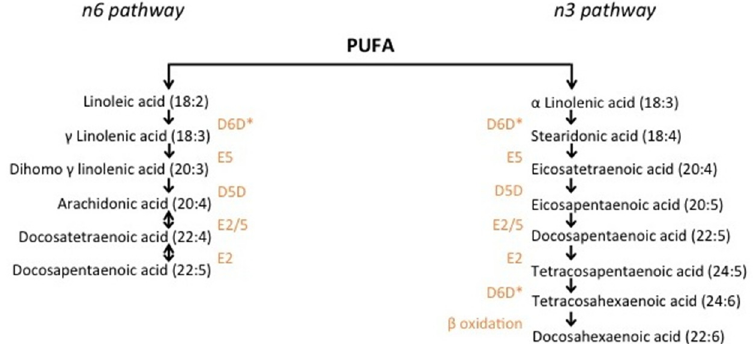
Figure 1. Synthesis of polyunsaturated fatty acids through the n ‐ 3 and n ‐ 6 pathways. Polyunsaturated fatty acid elongation from ALA and LA begins with desaturation by the D6D enzyme. Subsequent elongation and desaturation by the corresponding enzymes (orange) generates longer chain PUFA such as AA and EPA. n ‐ 3 and n ‐ 6 PUFA compete for the D6D, E5, D5D and E2 enzymes [11–15]. D5D: Delta 5 desaturase; D6D: Delta 6 desaturase; E: Elongase.*: Rate limiting step.